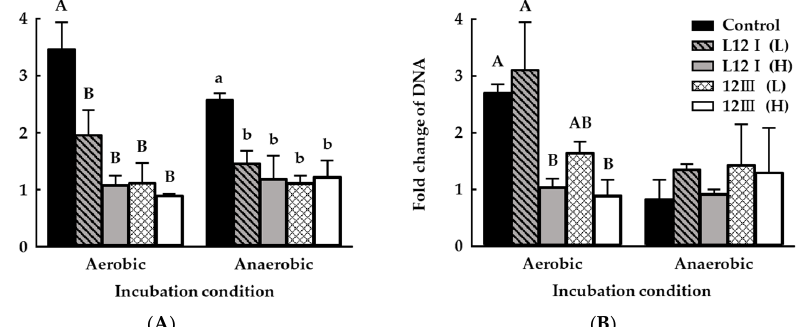
Figure 7. Inhibitory effects of selected bacterial strains against Clostridium aminophilum ( A ) and Proteus mirabilis ( B ). (L) Low-level inoculation (7.98 log CFU), (H) high-level inoculation (8.58 log CFU). Values represent the mean ± S.E. ( n = 3). The different capital letters (A, B) indicate statistically significant difference between different groups under the aerobic conditions (significance level at p < 0.05). The different minuscule letters (a, b) indicate statistically significant difference between different groups under the anaerobic conditions (significance level at p < 0.05).